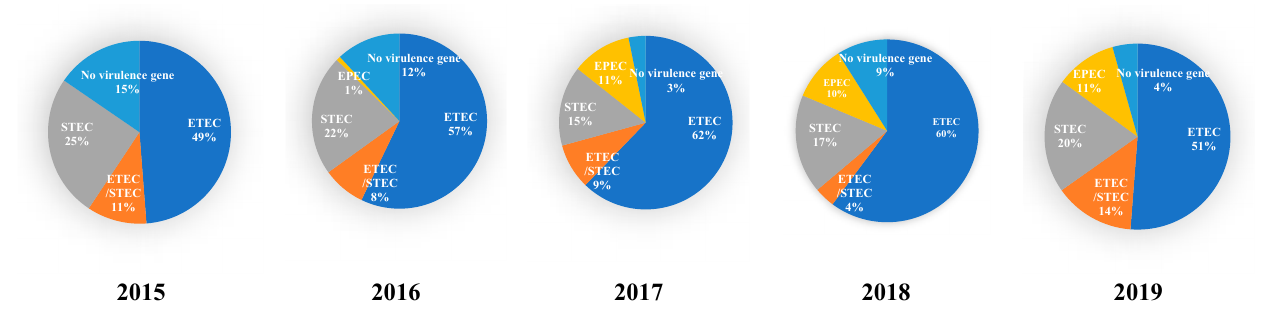
Figure 1. Pathotypes of E. coli isolated from the post-weaning piglets showing diarrhoea and oedema for 5 years (2015 to 2019).